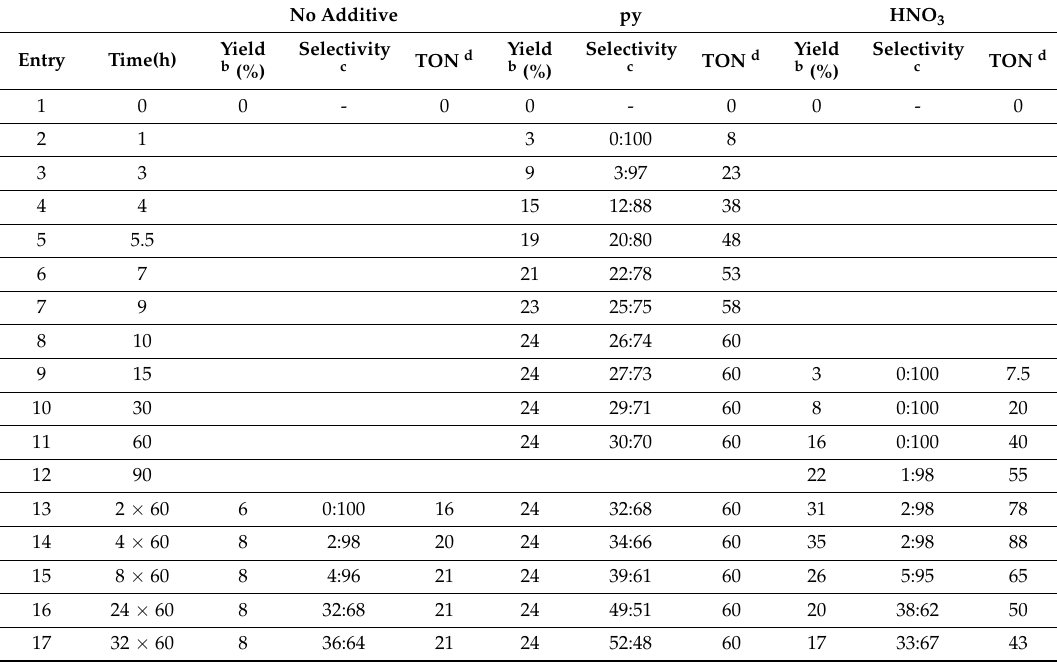
Table 4. Effect of the presence of an additive in the oxidation of cyclooctane catalyzed by 2 a